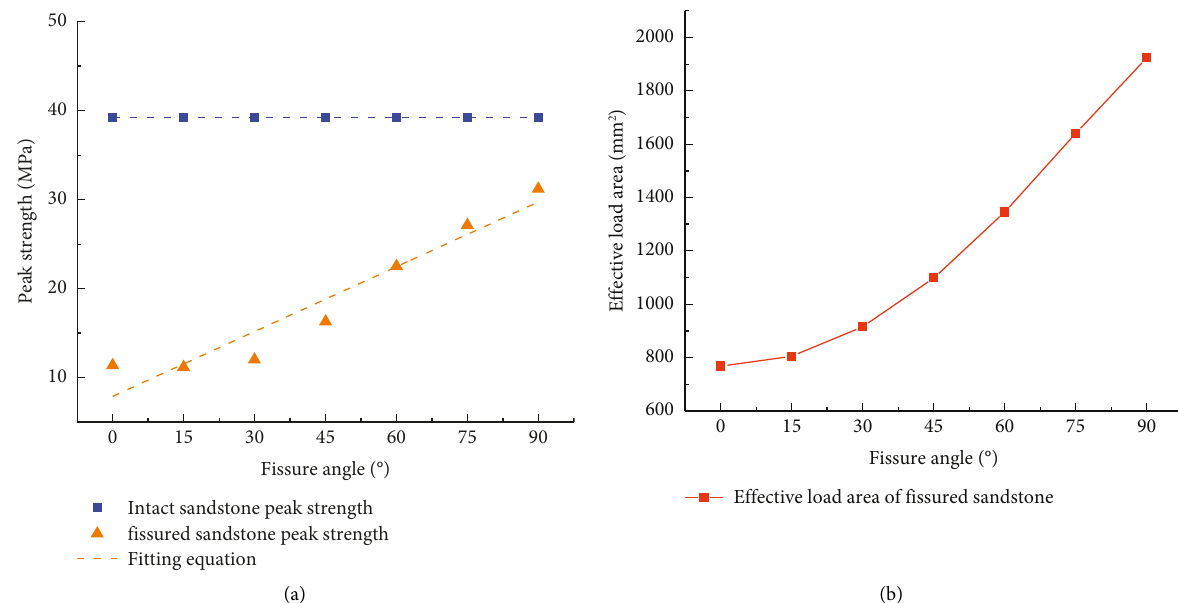
Figure 4: Peak strength of the fissured sandstone versus fissure dip angle. (a) Peak strength of the fissured sandstone versus fissure angle. (b) Relationship between the effective load area of the fissured sandstone and the fissure angle.